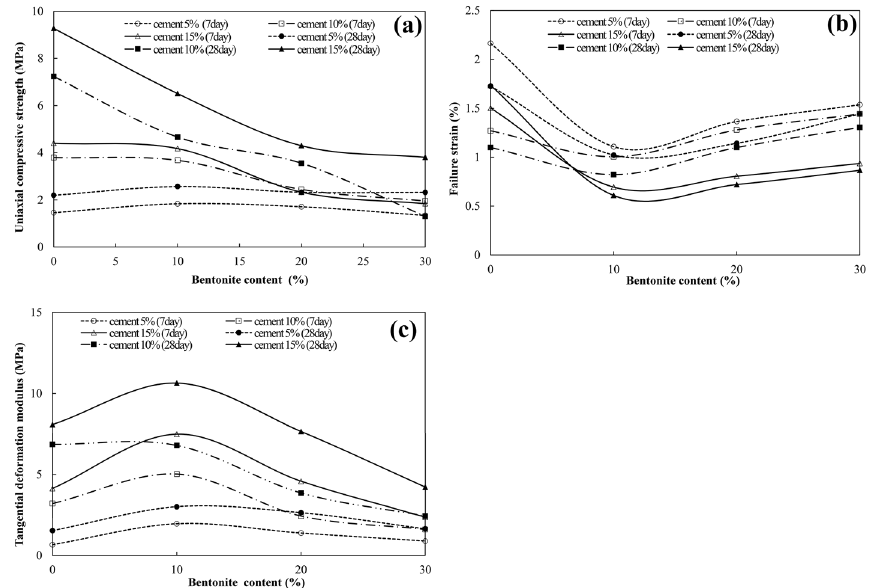
Fig. 11 The graph of uniaxial compressive strength graph a , failure strain graph b , deformation modulus graph c versus bentonite content for CSG mixtures containing bentonite additive and cured at both ages